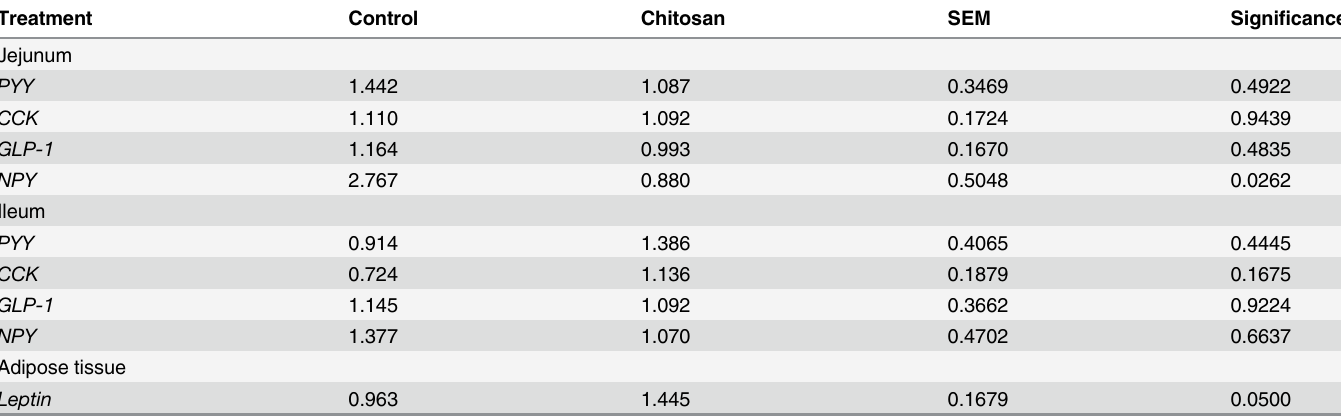
Table 6. Effect of dietary treatment on small intestine and adipose tissue regulators of appetite gene expression (least square means and SEM).